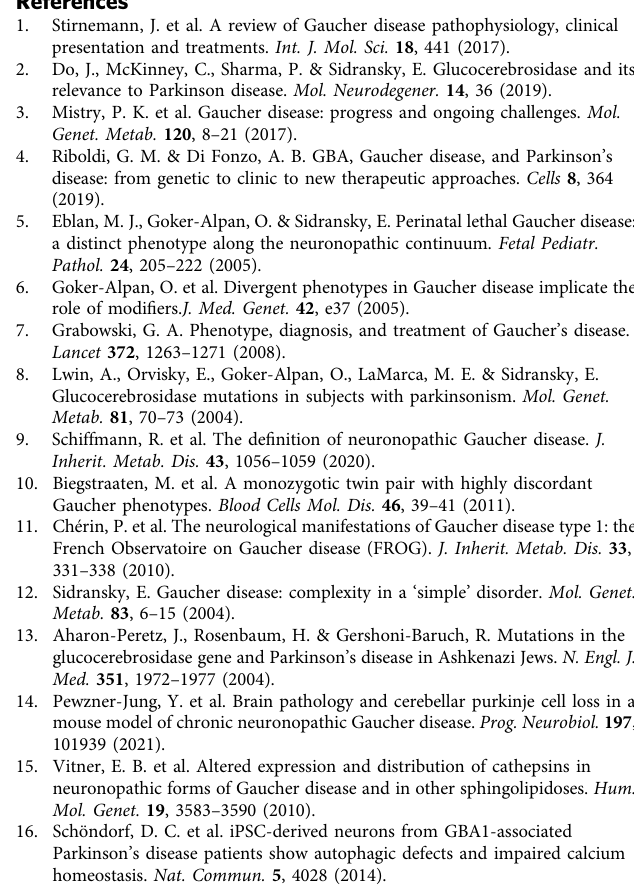
1:200. Pictures were acquired with the Leica TCS SP8 confocal microscope (Leica), analyzed with Fiji software and brightness/contrast was adjusted equally. Nuclear localization of YAP in NPC and neurons was evaluated in 2 to 5 pictures per condition for each biological replicate with the Intensity Ratio Nuclei Cytoplasm Tool plug-in of the Fiji